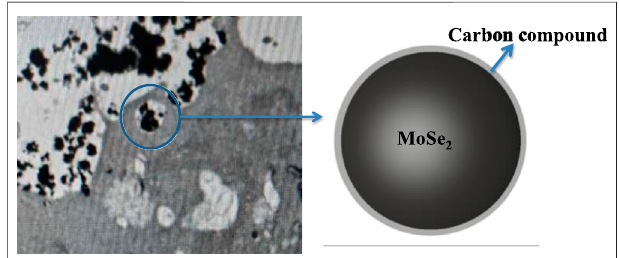
FIGURE 12 | Cytophagy of the carbon-doped MoSe 2